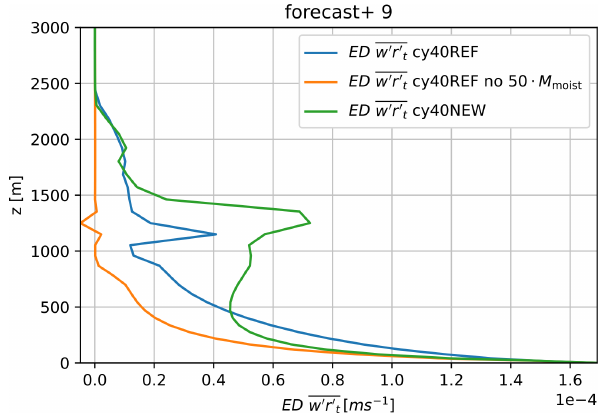
Figure 9. The eddy diffusivity (ED) turbulent moisture transport for ARM at the ninth simulation hour with three different model versions: cy40REF (blue), cy40REF but without 50 · M moist term (see Sect. 2.3) (orange), and cy40NEW